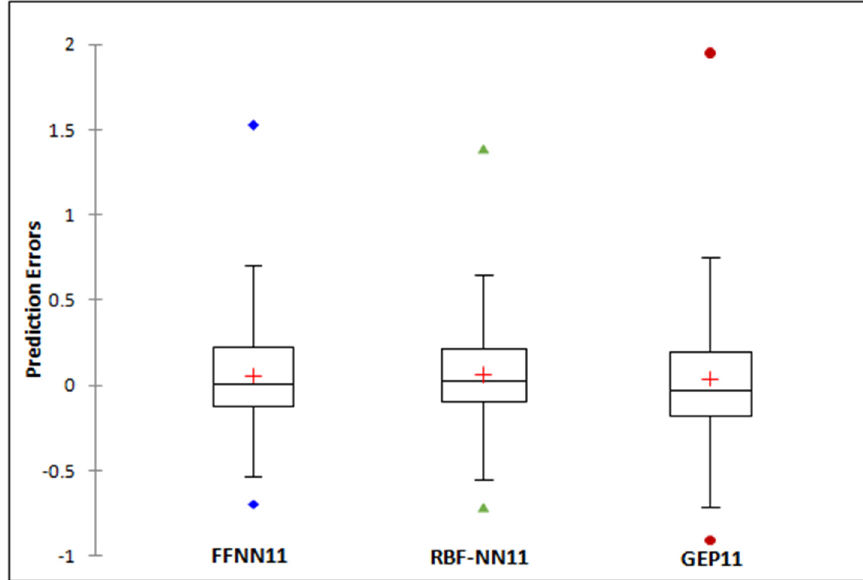
Figure 9. Box plot for best performing models.